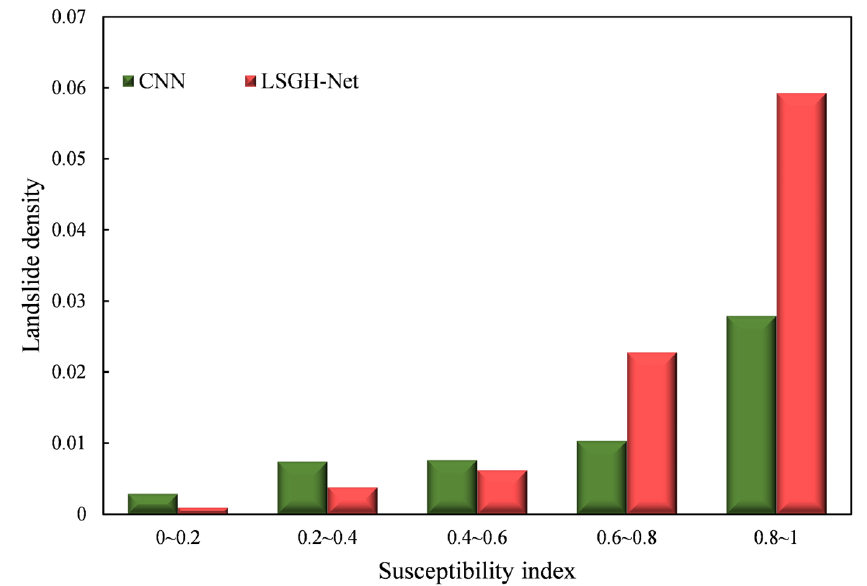
Figure 11. Comparison of landslide density of the CNN and LSGH-Net.